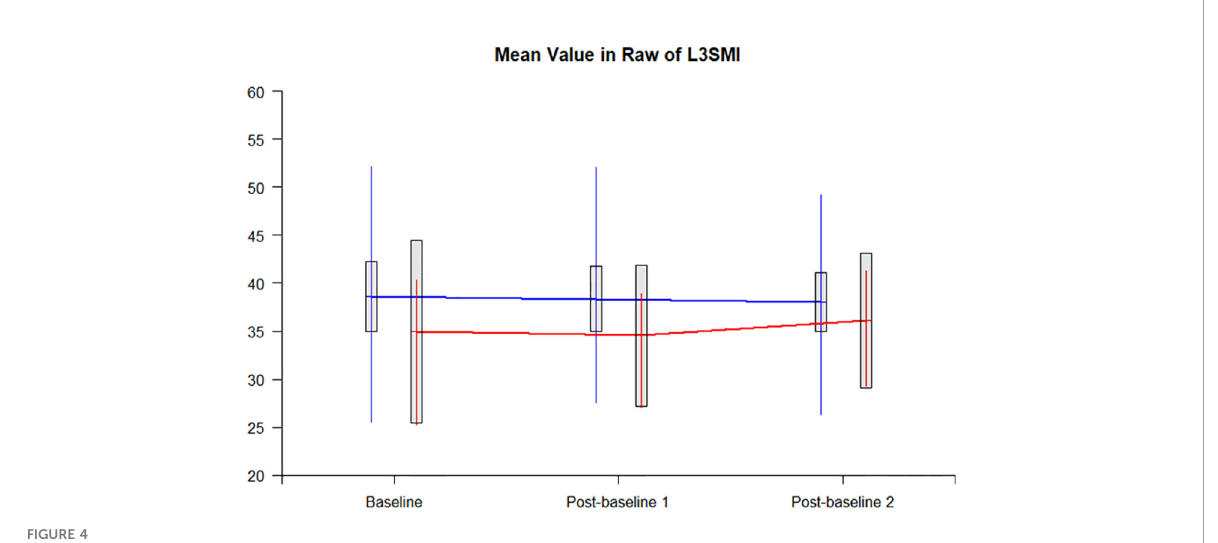
FIGURE 4 The trend of dynamic